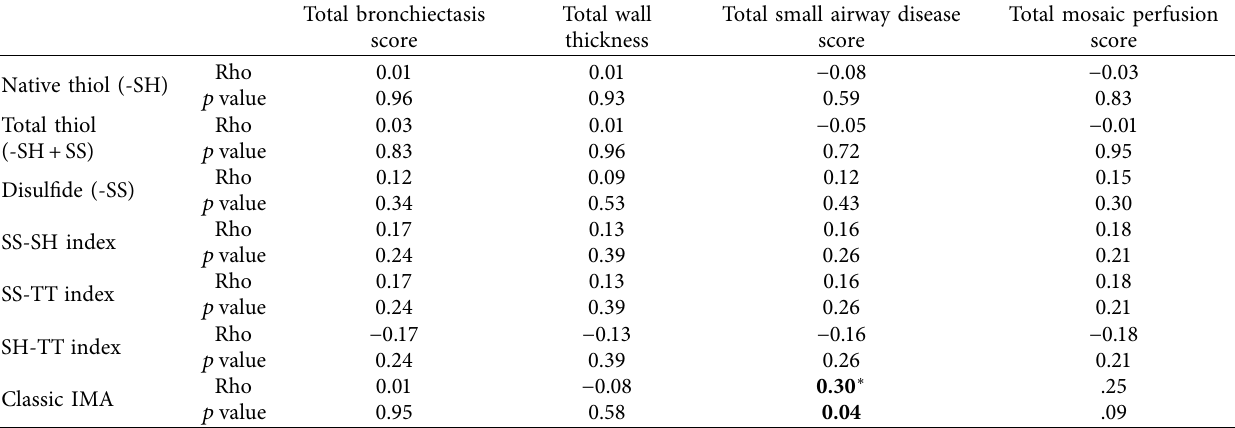
Table 3: Analyzing the correlation between the oxidative stress parameters in the bronchiectasis group ( n � 49) with disease scores. Total bronchiectasis